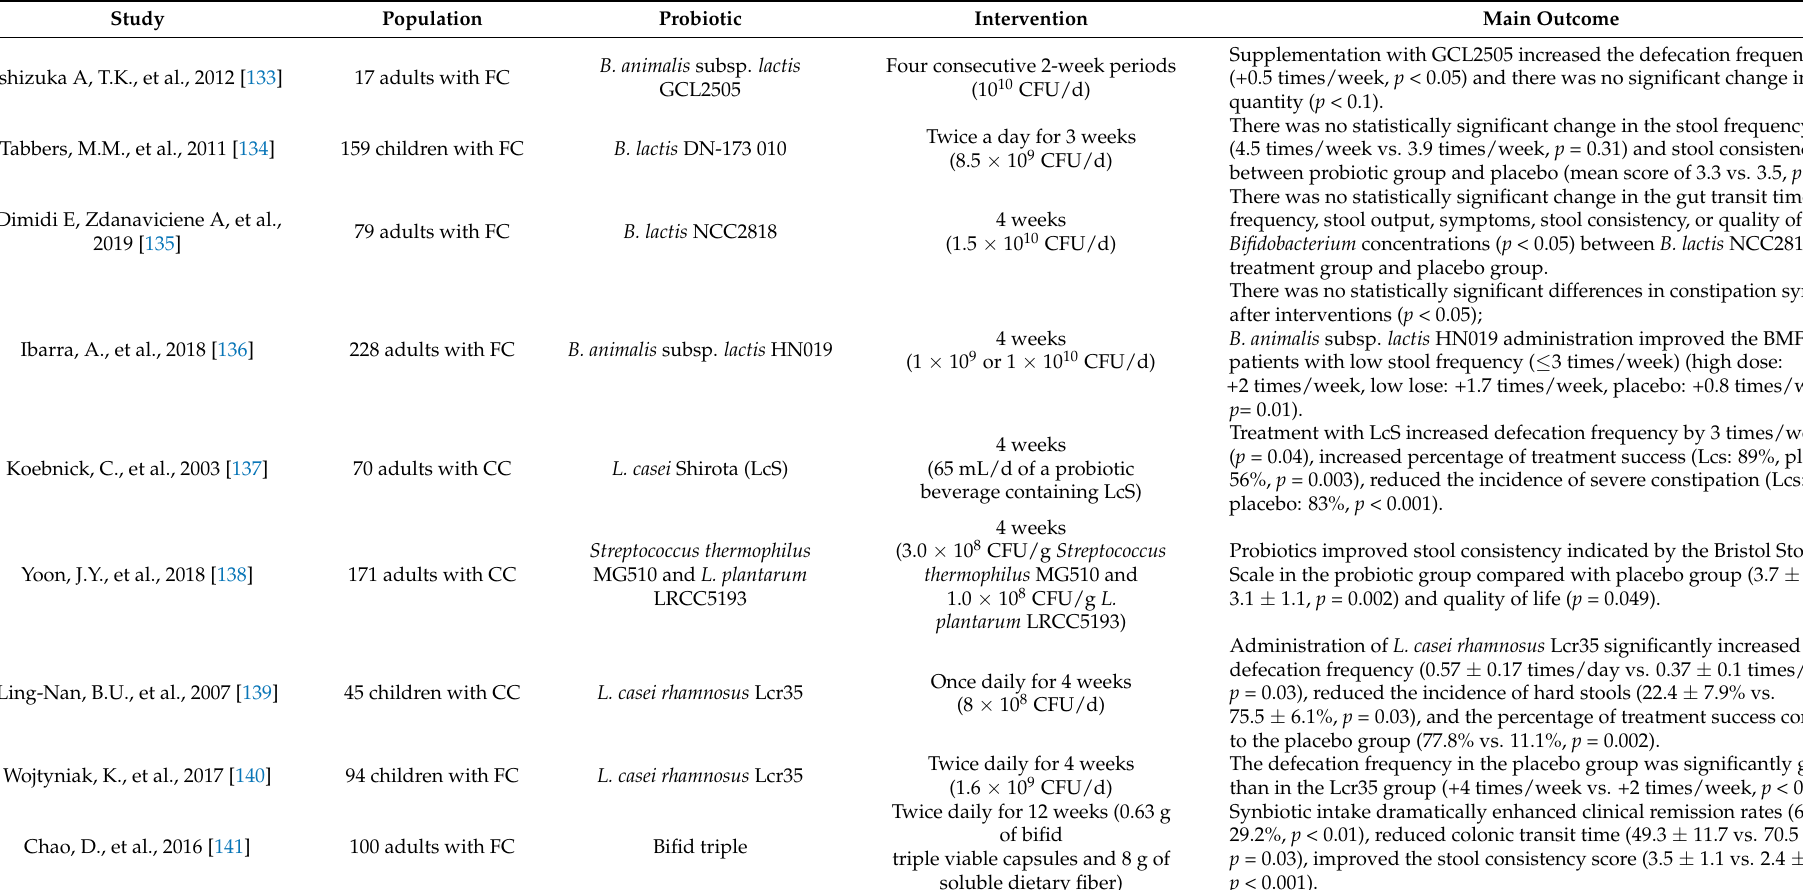
Table 4. Randomized controlled and parallel-group trials of micro-ecological intervention for constipated individuals in children and